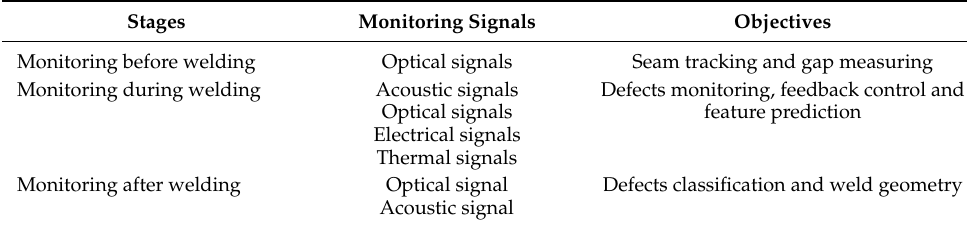
Table 1. Sensor technology for welding defect detection at the various stages. Adapted from